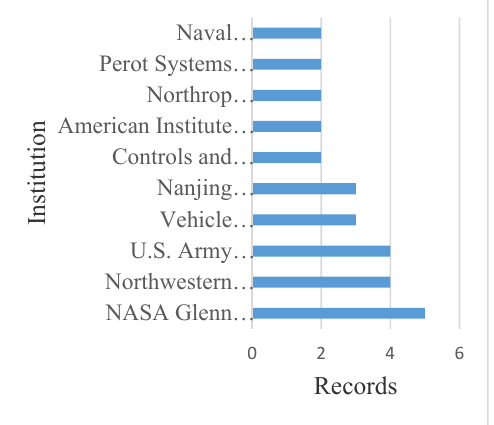
Figure 10. List of the top 10 scientific institutes in terms of published articles.